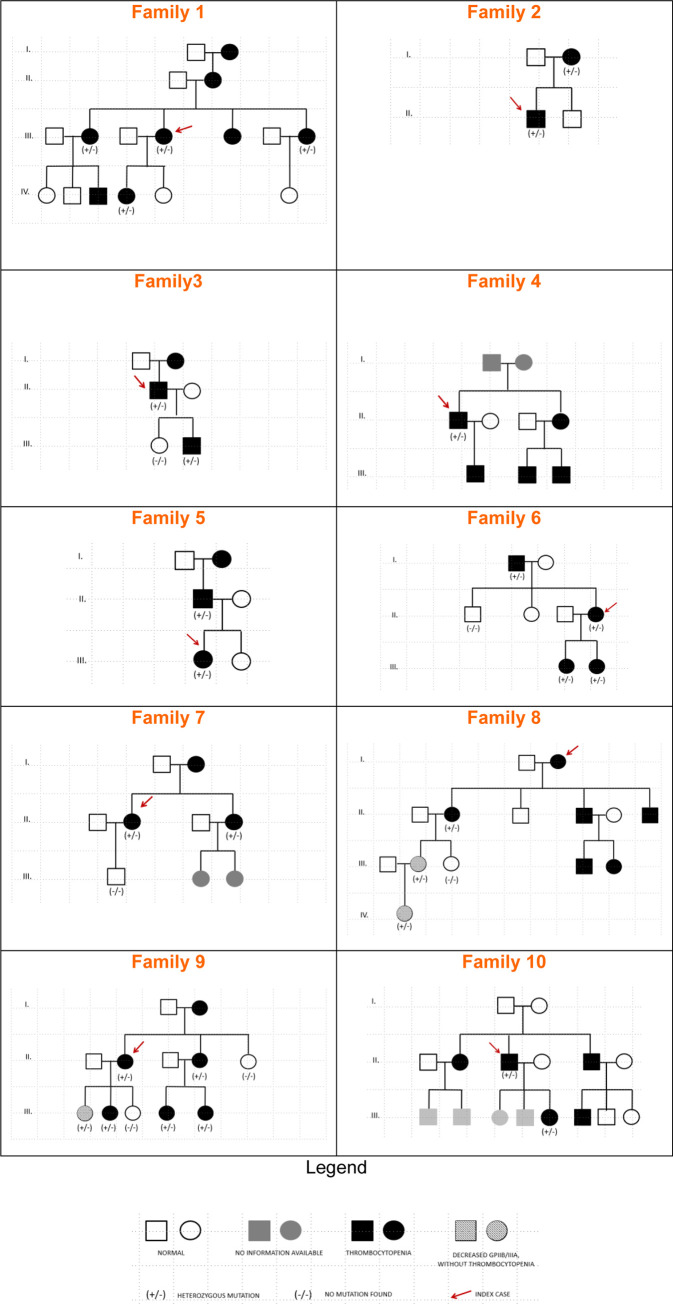
Pedigrees of the GTLS families described in this study.